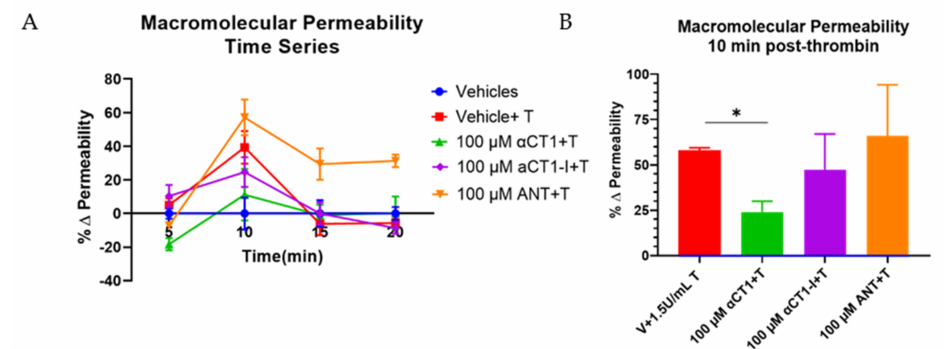
Figure 4. α CT1 requires ZO1 binding competency to prevent thrombin-induced hyperpermeability in HMEC-1 cell monolayers. ( A ) Representative time course of macromolecular flux to 4.5 kDa FITC-dextran across the endothelial monolayer, from the top (apical) to the bottom (basolateral) compartment of Transwell chambers. The percentage change in absolute permeability was calculated from fluorescent readings of samples taken from the bottom compartment at 5, 10, 15, and 20 min post- thrombin stimulation. Measurements at each time point were normalized to vehicle control. ( B ) The change in permeability at the time point of maximum thrombin disruption (10 min), normalized to vehicle control, were averaged across experiments. * p < 0.05 vs. Vehicle control; N =